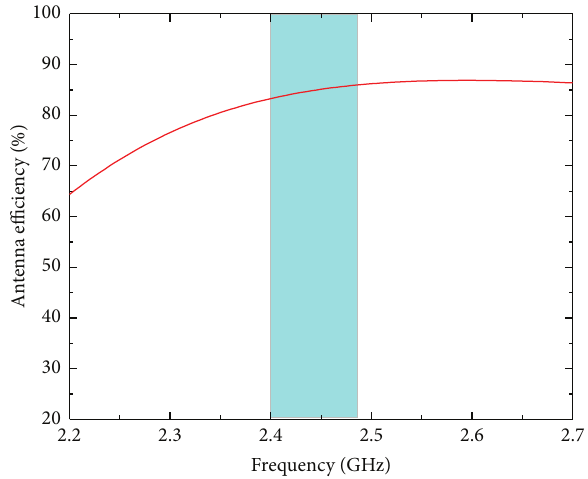
Figure 12: Simulated radiation efficiency of proposed antenna.